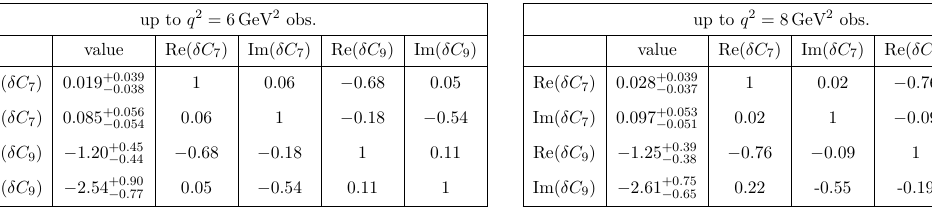
Table 2 . Fit results and correlation coe(cid:14)cients for (cid:14)C 7 and (cid:14)C 9 using observables up to q 2 = 6 GeV 2 in the left table and up to q 2 = 8 GeV 2 observables in the right table.